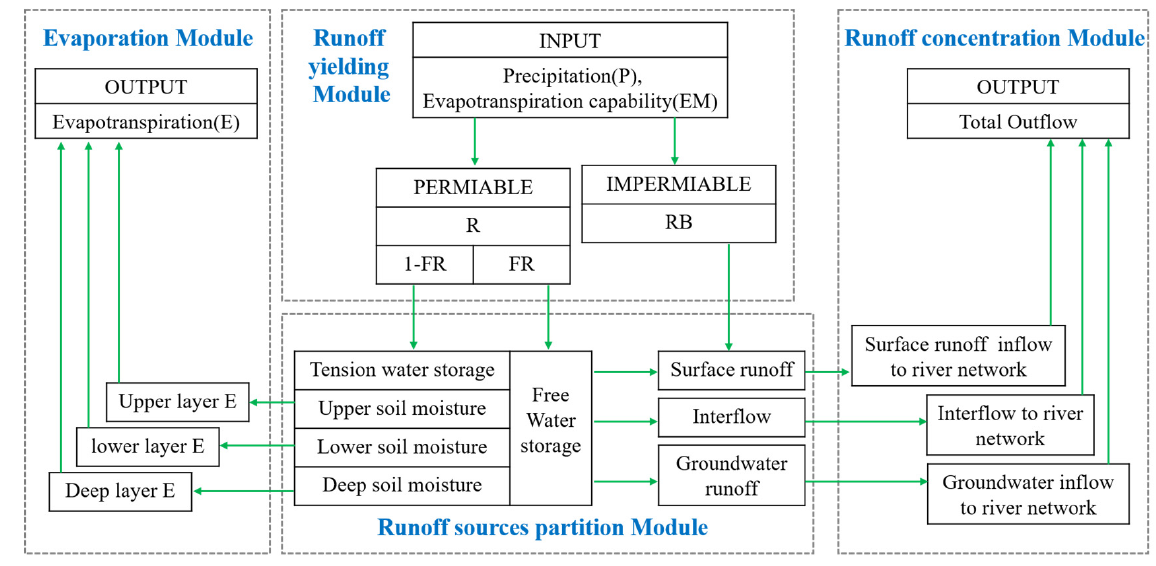
Figure 2. Flowchart of the XAJ